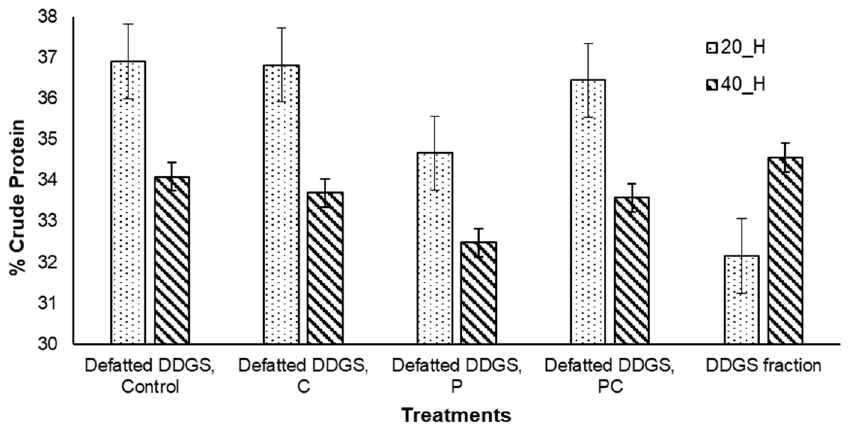
Figure 5. Effects of different enzymes on the crude protein variation in defatted DDGS (C—5% cellulase; P—5% protease; PC—5% protease + 5% cellulase; control: no enzyme; fractions, 20_H: number-20-sieved aspirated heavy fraction and 40_H: number-40-sieved aspirated heavy fraction).